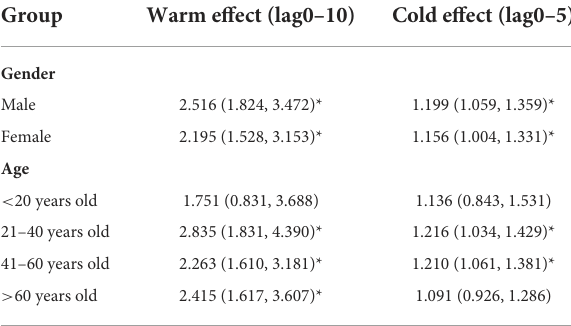
TABLE 4 Cumulative warm and cold effects of temperature on urolithiasis inpatients of different genders and ages.